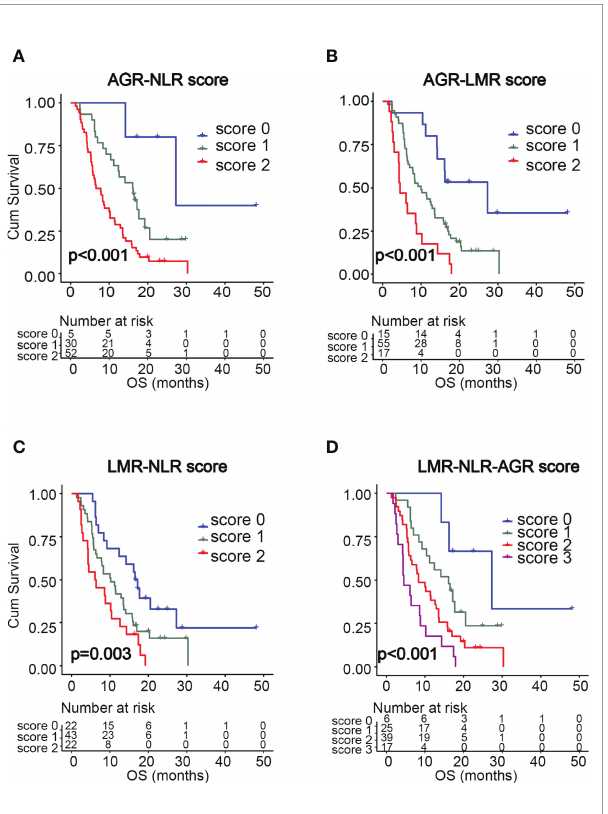
FIGURE 2 | Kaplan-Meier survival curves of GBM patients based on the scoring systems of AGR-NLR (A) , AGR-LMR (B) , LMR-NLR (C) , and LMR- NLR-AGR (D) .